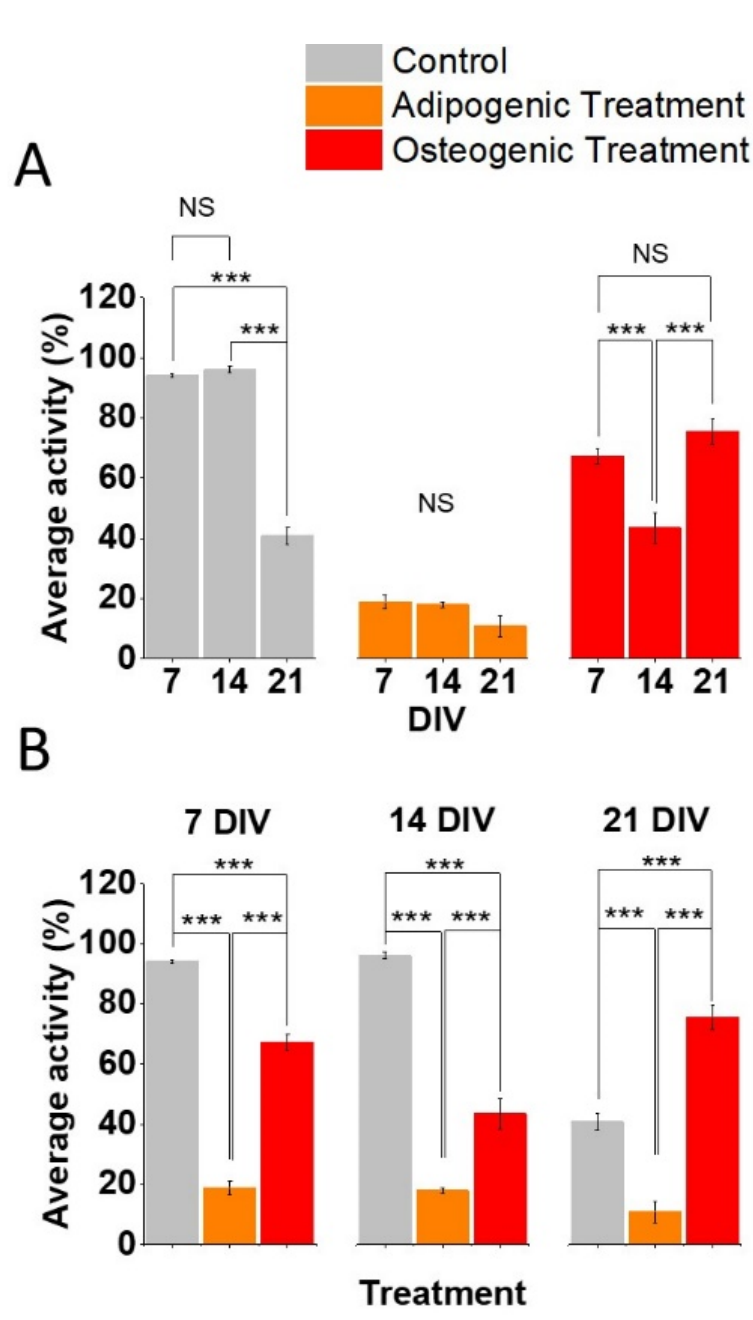
Figure 2. Both time and differentiation treatment affect the fraction of cells with Ca 2+ oscillations. Untreated ASCs exhibited a significantly lower activity at 21 DIV (( A ), left ). Adipogenic treatment is associated with a strong reduction of the activity for all the timepoints (( A ), middle ) while the osteogenic treatment shows a decrease at 14 DIV and a subsequent increase at 21 DIV (( A ), right ). Cells undergoing adipogenic and osteogenic differentiation showed decreased activity, in comparison to controls, at 7 DIV (( B ), left ) and 14 DIV (( B ), middle ). However, the ASCs treated with osteogenic differentiation medium showed increased activity at 21 DIV vs. both the cells treated with adipogenic differentiation medium and control ones, while the adipogenic one was still lower than controls (( B ), right ). Multiple pairwise comparisons were carried out with t -test with Bonferroni correction: *** = p ≤ 0.001.